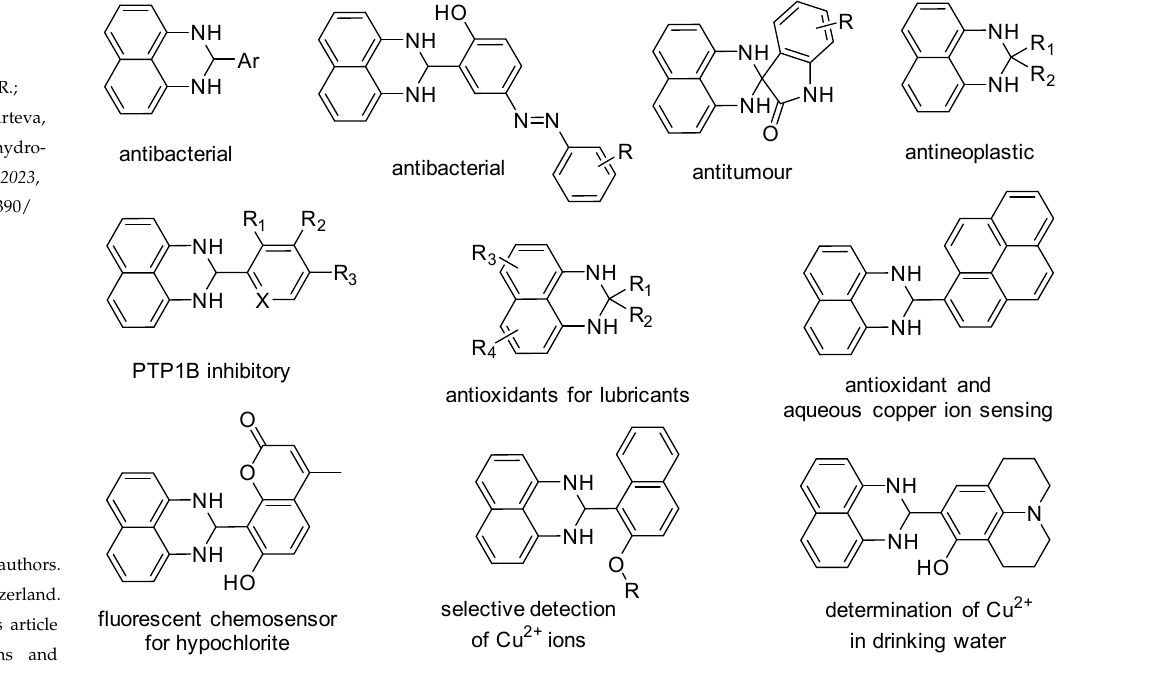
Figure 1. Representatives of 2,3-dihydro-1H-perimidine derivatives showing various applications. Numerous derivatives display variable bioactivities, such as antibacterial [9,10], anti- tumor [11], anti-neoplastic [12], PTP1B inhibitory [13], etc., and applications such